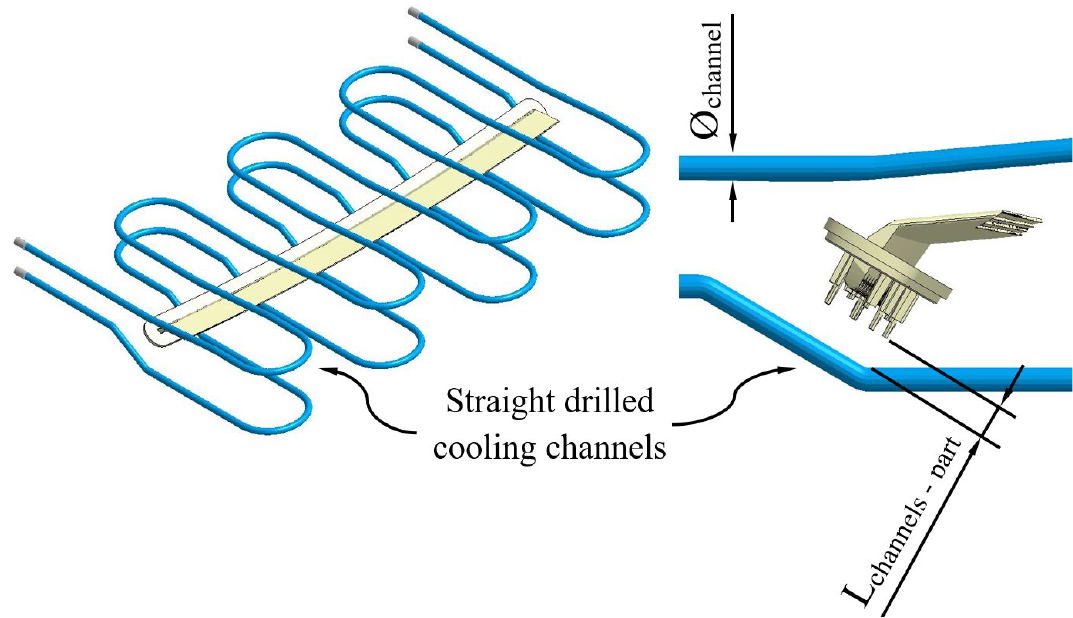
Figure 6. Straight drilled cooling channels design. Table 5. Geometric variables of the traditional cooling system design.